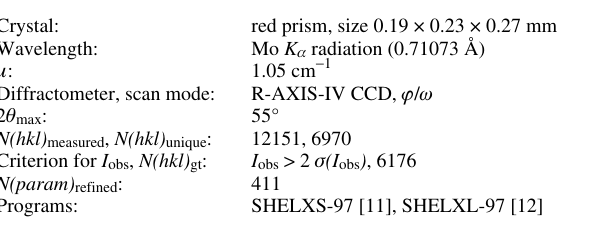
Table 1. Data collection and